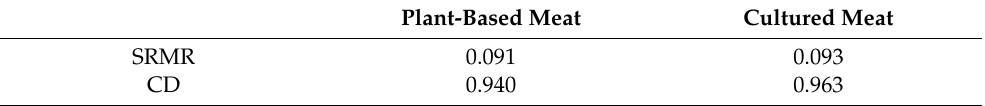
Table 4. Group-level goodness of